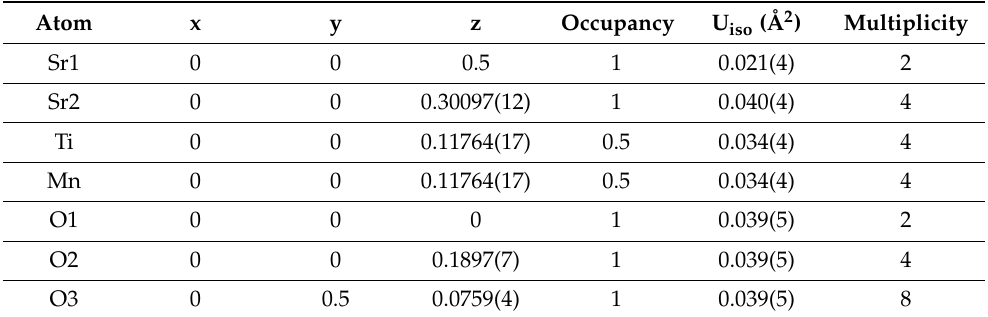
Table 2. Refined structural parameters of Sr 3 TiMnO 7 from powder X-ray diffraction data. Space